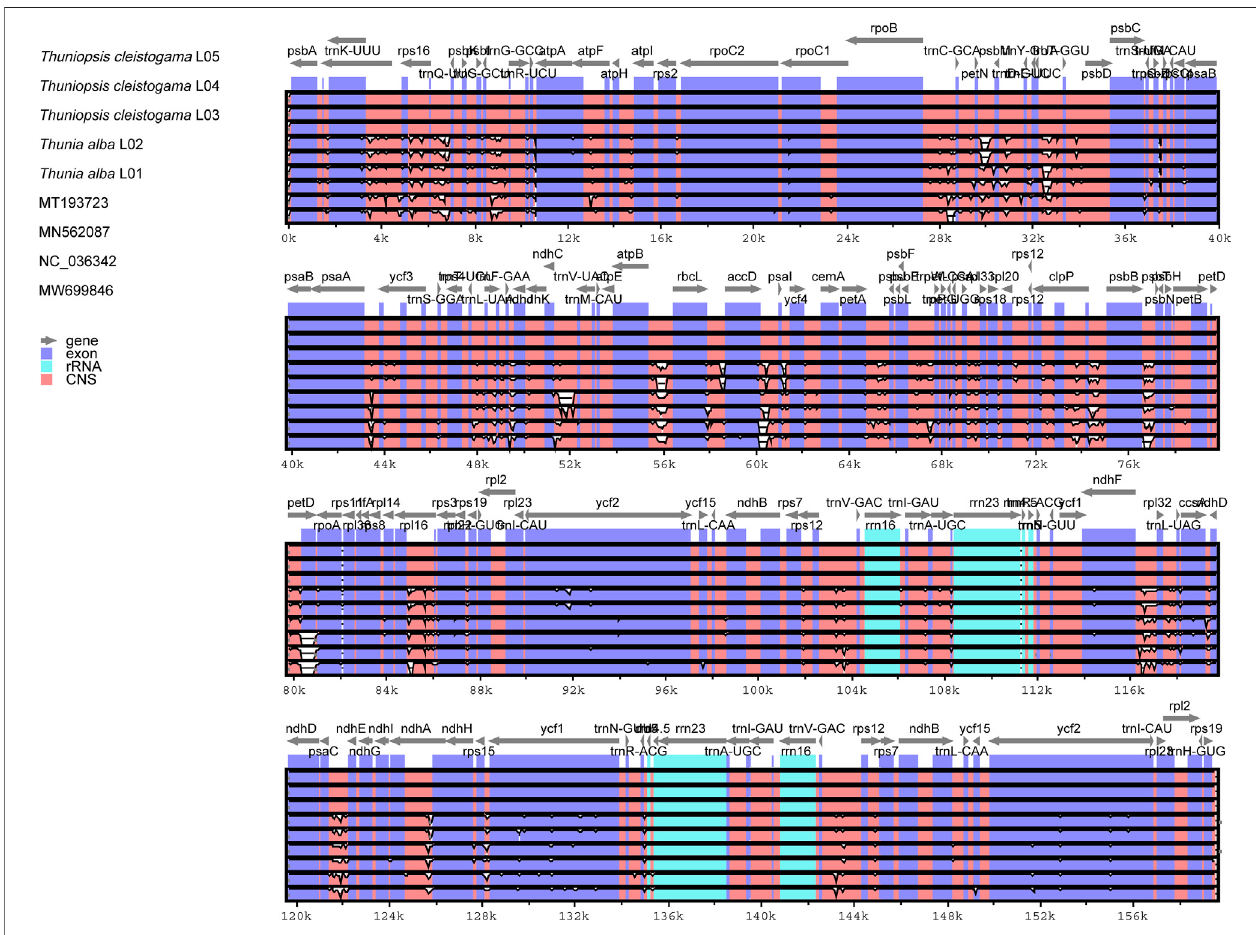
FIGURE 7| Comparison ofnine cp genomes of sixtaxa using mVISTA program with Thuniopsis cleistogama _L04 cp genome asa reference. The top gray arrows above the alignment indicate genesand their orientation. Acut-off of70% wasused for theplots. Genome regions are color coded. Blue and red areas indicate protein- coding regions and the conserved non-coding sequences (CNS) regions, respectively.